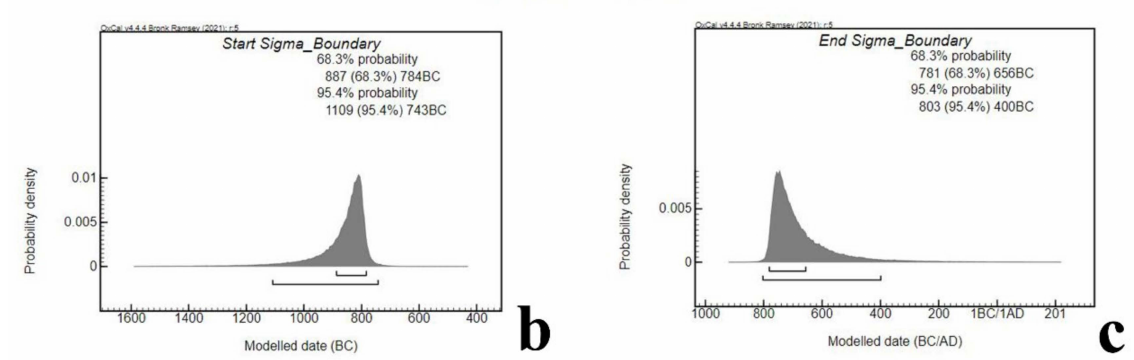
Figure 9. An illustration showing the summary dates as well as modeled start and end dates. ( a ). the summary of dates, including the start, end and all collected samples. ( b ). the calibration of start date ( c ). the calibration of the end